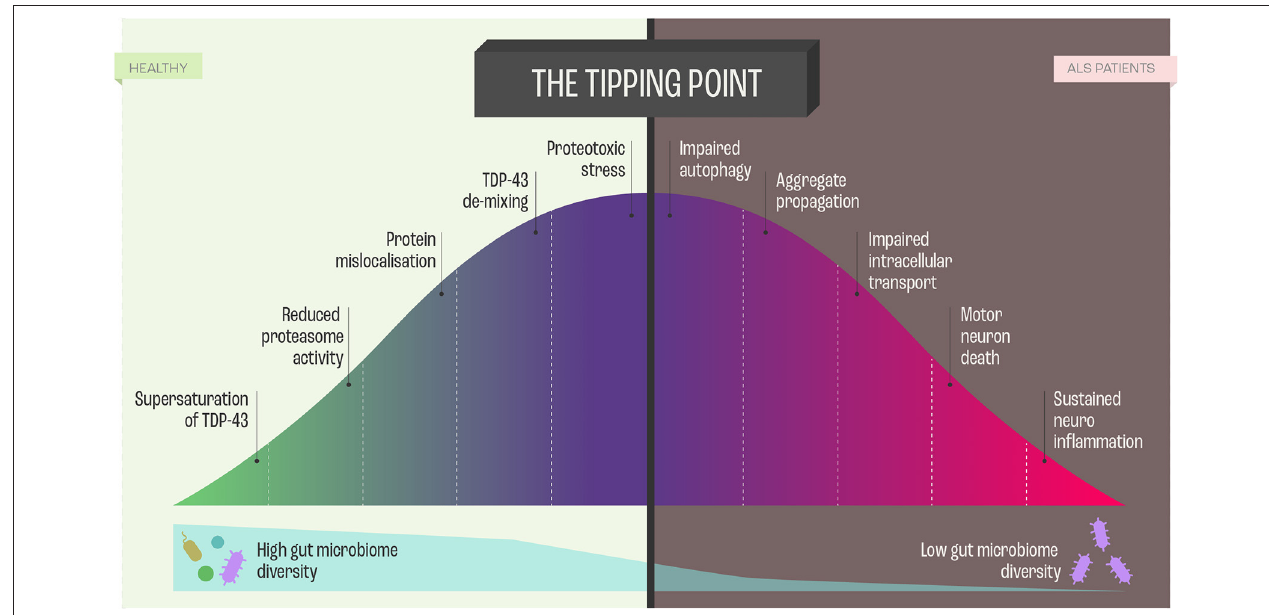
FIGURE 4 | Proteome Homeostasis and functional consequences of this imbalance in Amyotrophic Lateral Sclerosis (ALS). Dysregulation of proteome in ALS is a unifying feature, and the imbalance results from processes, such as transcription, translation, mRNA metabolism, cellular trafficking, autophagy -all leading to neurodegeneration and cell death via perturbed